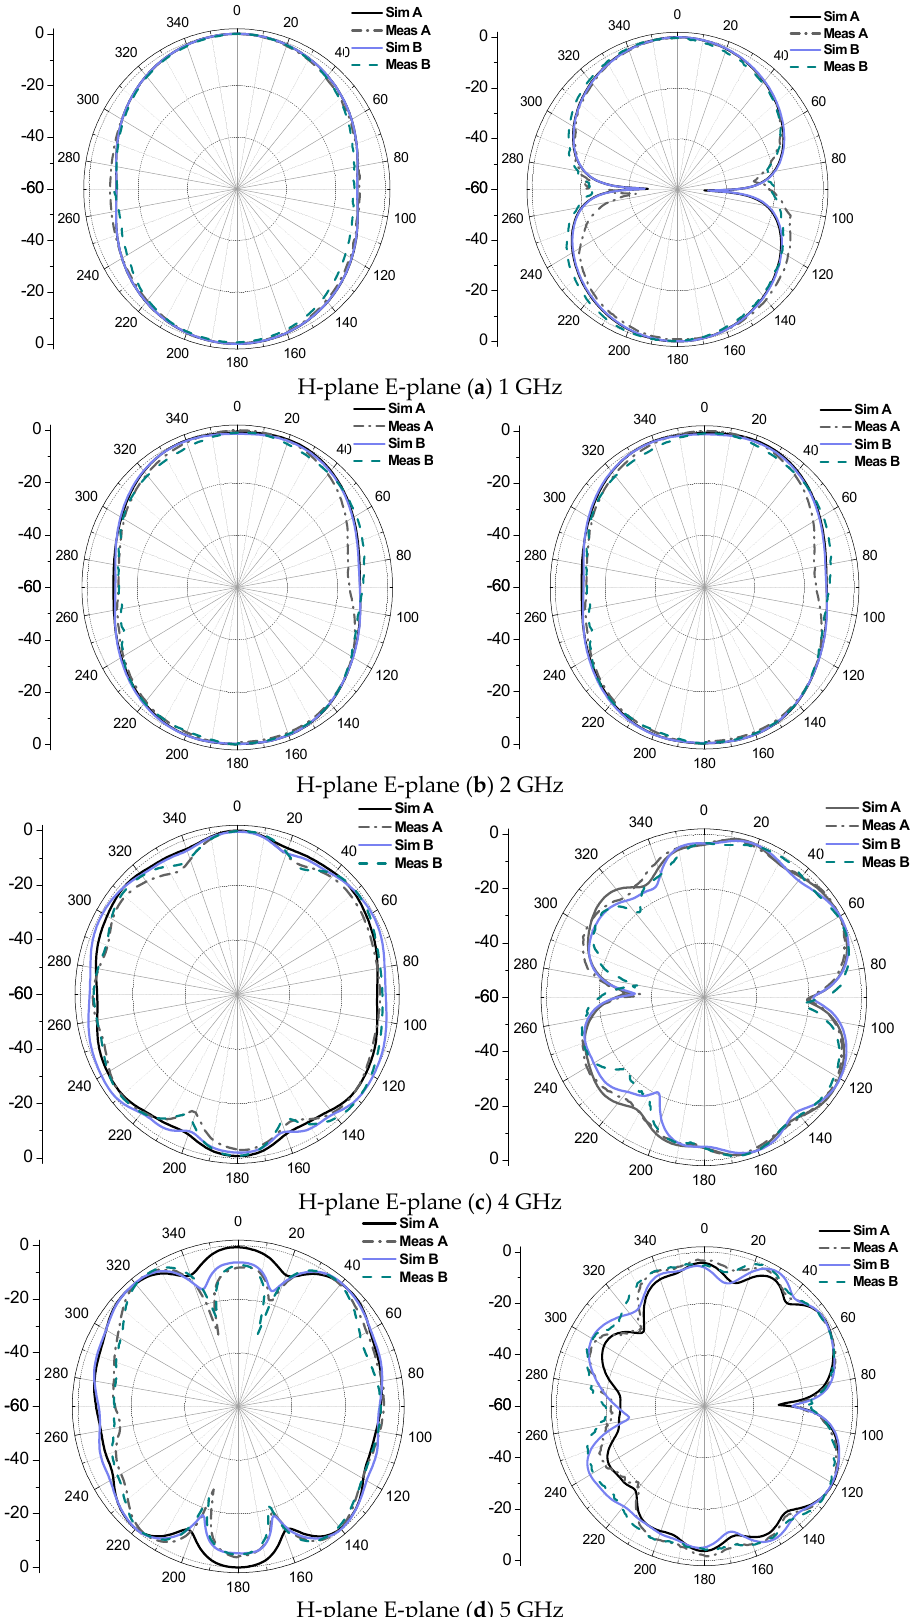
Figure 11. Radiation patterns of the proposed antennas; ( a ) 1 GHz; ( b ) 2 GHz; ( c ) 4 GHz; ( d ) 5 GHz.